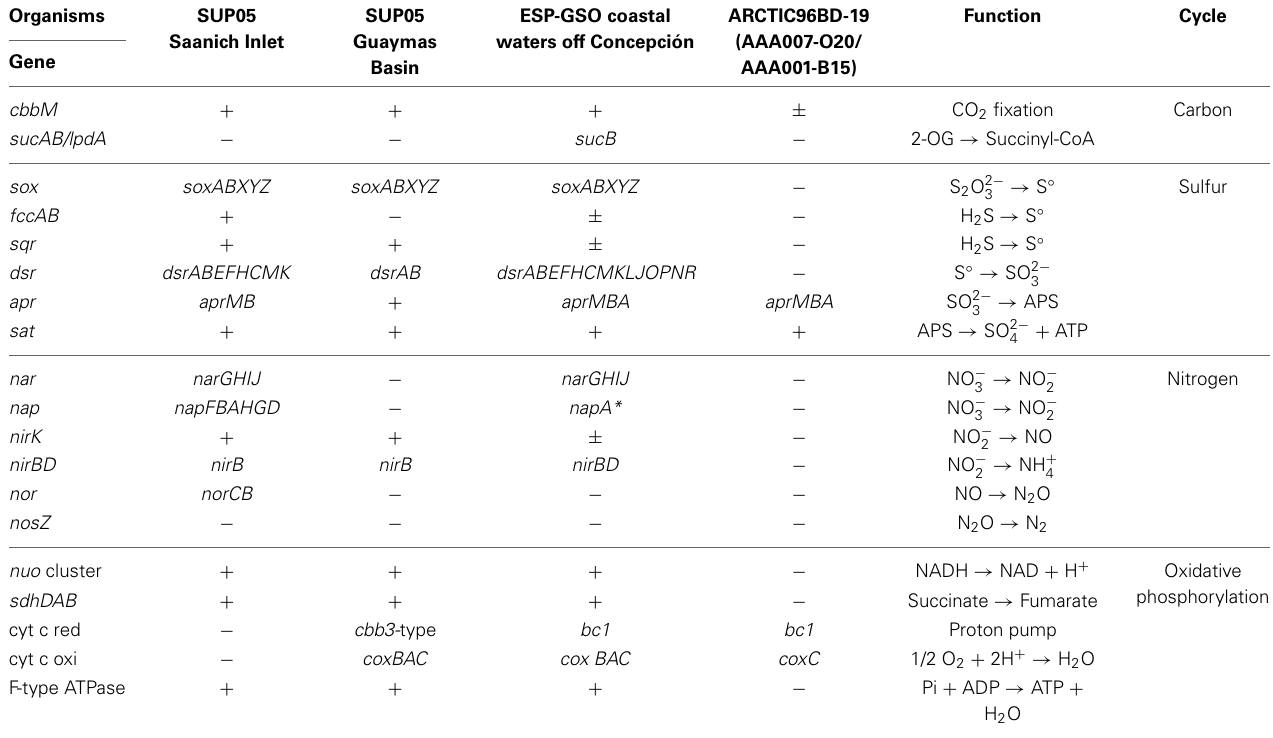
Table 1 | Summary of genes and gene clusters reconstructed for GSO cluster from the oxygen-deficient coastal waters off Concepción (ESP), compared with those from Saanich Inlet (SI), the hydrothermal vent plumes in Guaymas Basin (GB) and two ARCTIC96BD-19 representatives from the South Atlantic Sub-Tropical